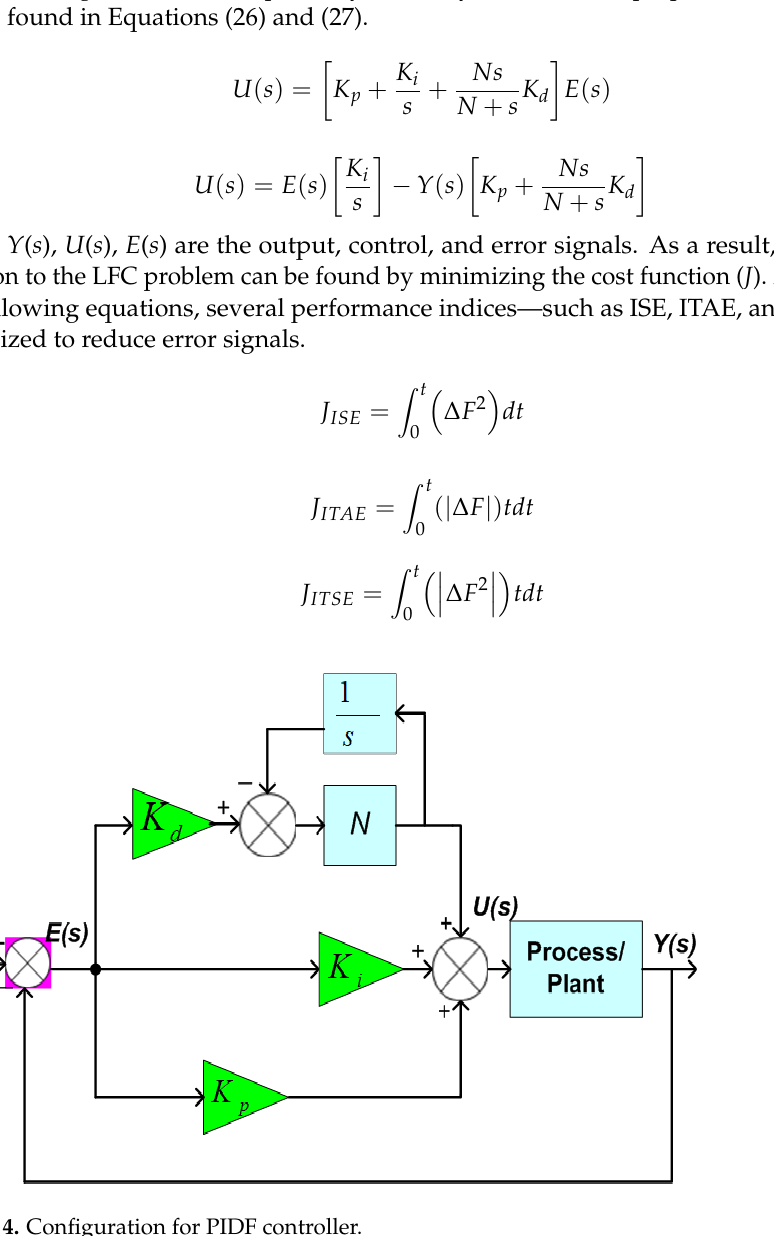
Figure 5. Configuration for the I-PDF controller.